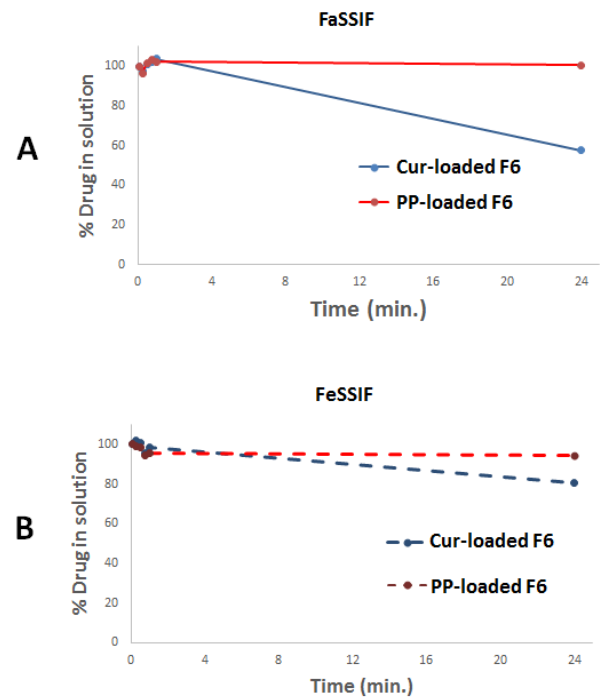
Figure 5. The percent of CUR and PP remaining in solution during 24 hrs time after dilution in ( A ) fasted and ( B ) fed state simulated intestinal fluid (FaSSIF and FeSSIF, respectively). SNEDDS was represented by F6 (BSO/988/TcP/CrRH40 [20/20/10/50]), CUR: curcumin and PP: piperine.